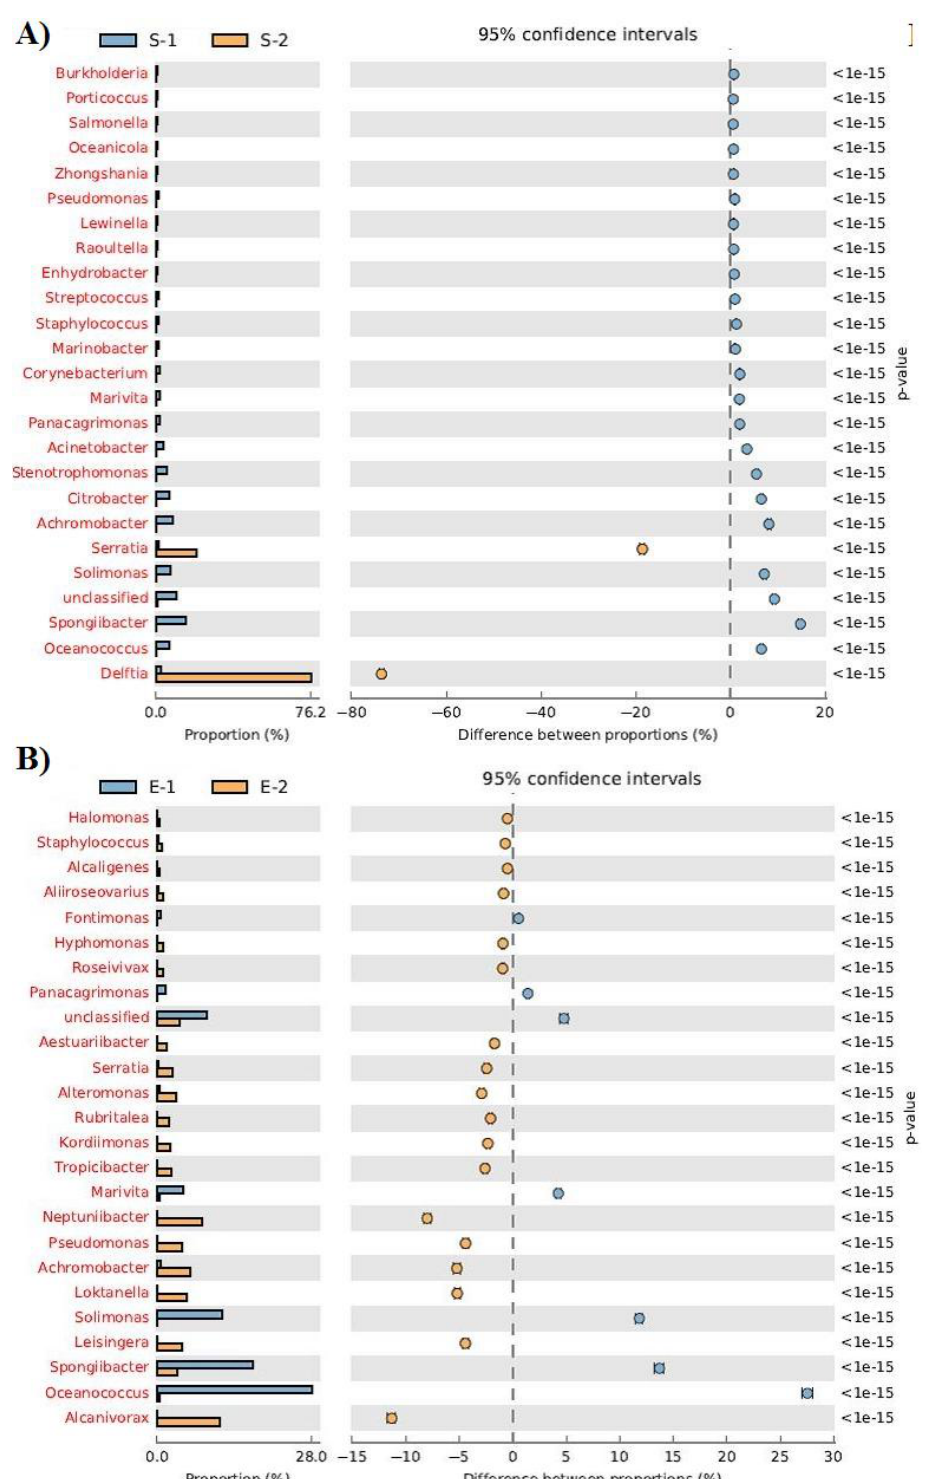
Fig. 6. Analysis of bacterial abundance before and after heat treatment. (a) S. trocheliophorum (b) E. ancora . The left side shows the abundance ratio of the different species in the two sample, the middle shows 95% confidence interval, Species classification abundance of the proportion of the difference, the right value of the P-value, P-value <0.05, representing significant differences, The name of bacteria is marked with red. (Only 25 of the lowest P values are